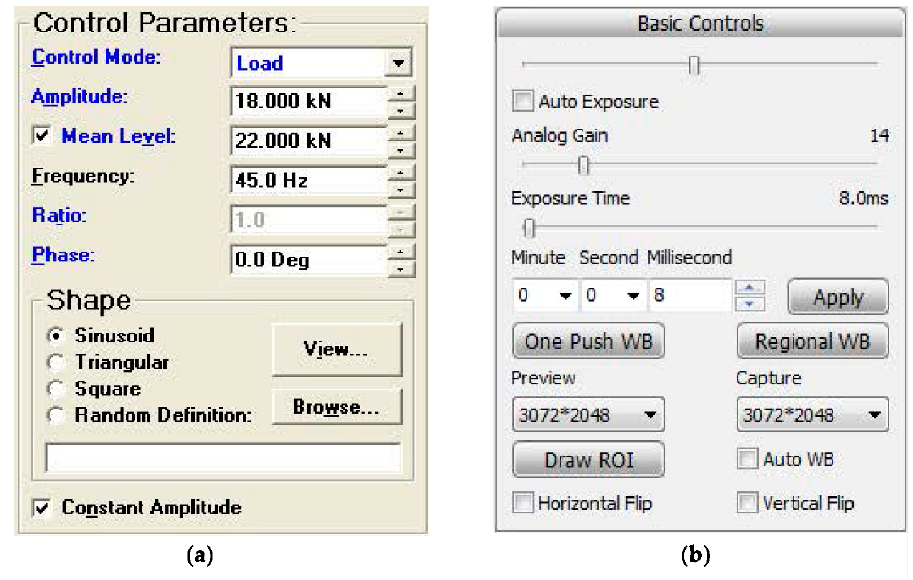
Figure 9. Experimental setups: ( a ) the INSTRON 8800 fatigue testing machine; and ( b ) the digital microscope system.